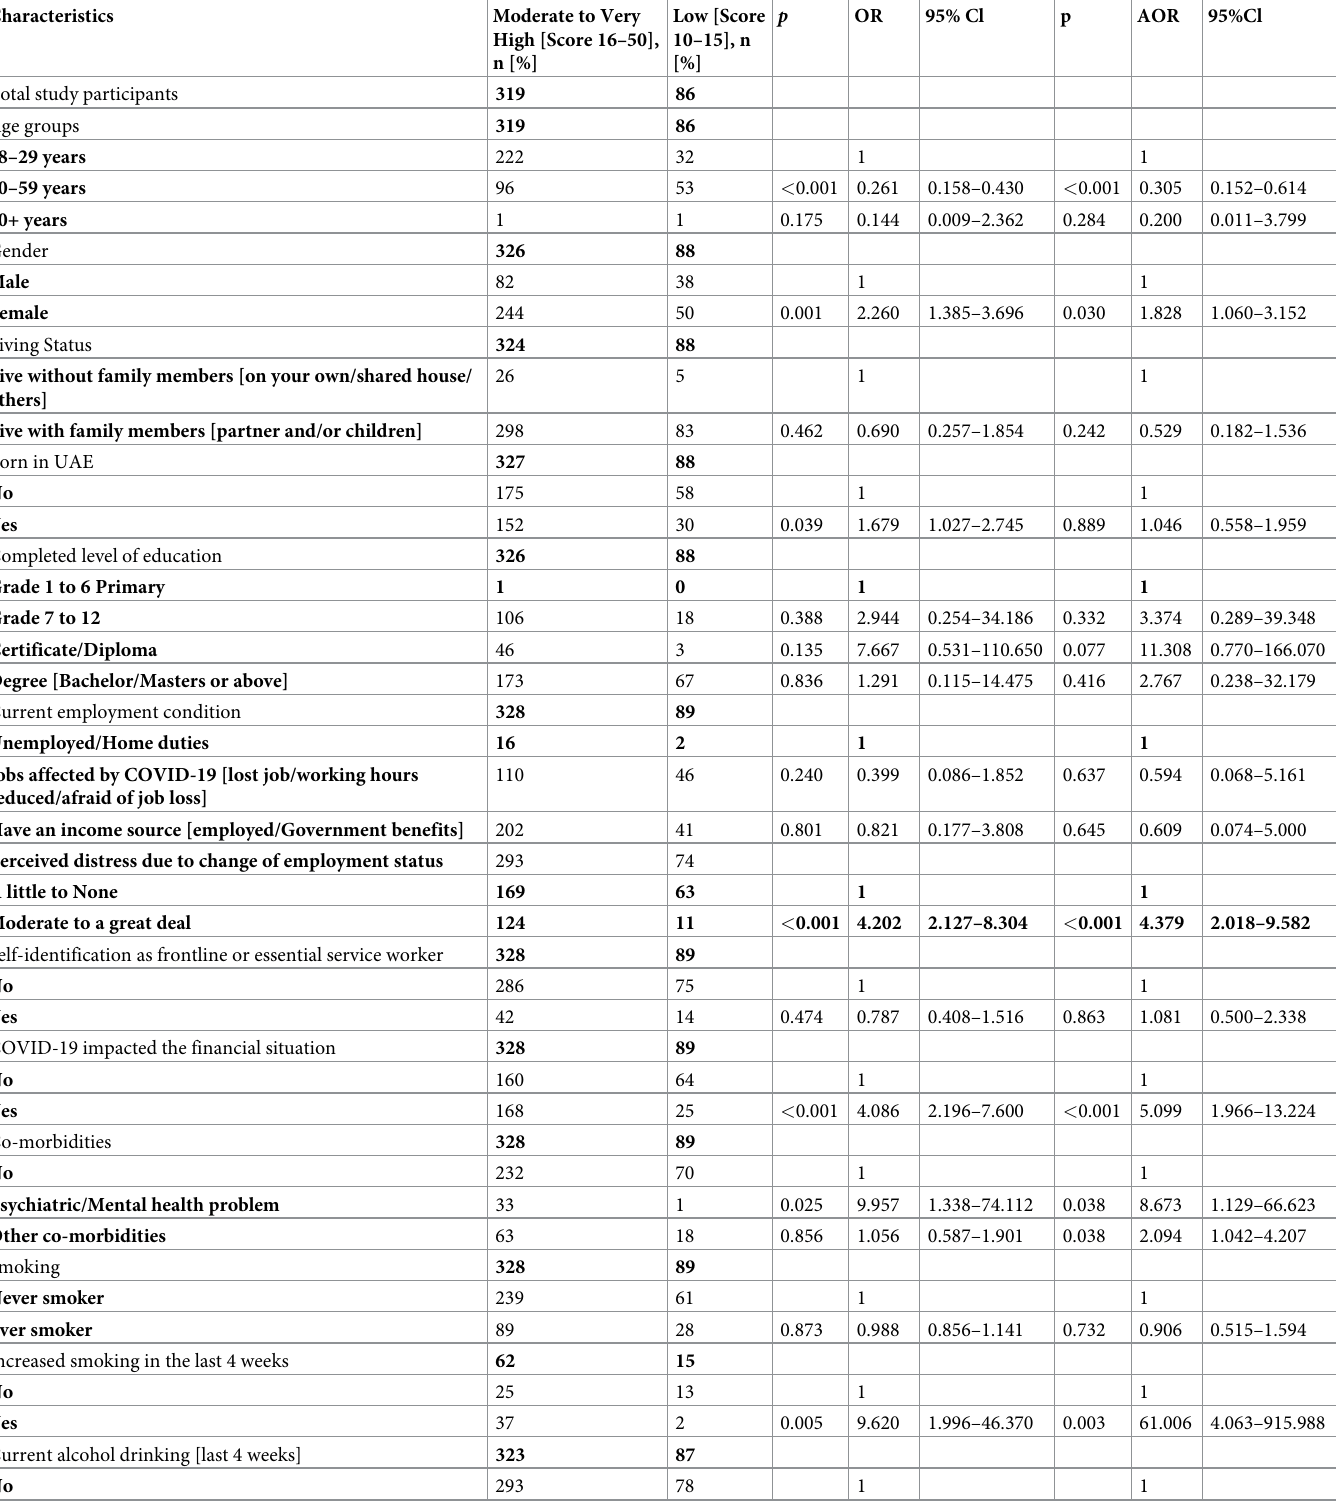
Table 2. Factors related to high psychological distress among the study population [based on K10 score] in UAE [November-2020].